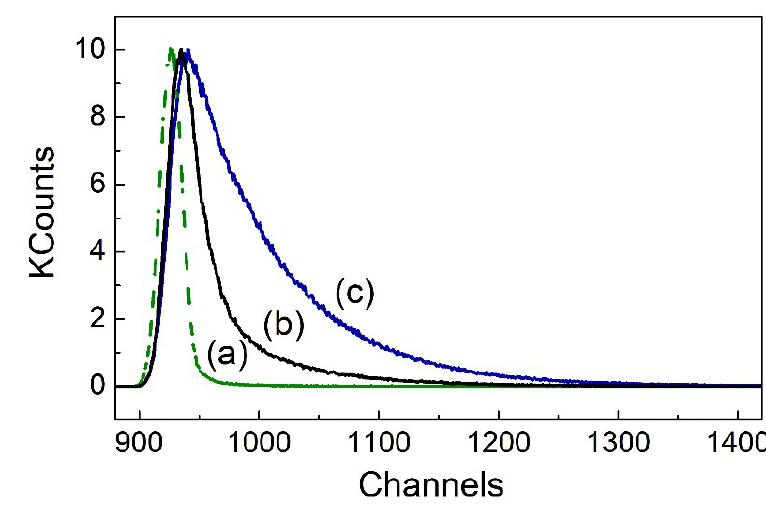
Figure 4. Lifetime measurements of compound 1 in THF ( a ), ethanol ( b ) and alkaline aqueous solutions ( c ) (concentration of 1 × 10 −5 mol/L). The time calibration is 5.487 × 10 −11 s/ch. Table 2. Lifetime results for compound 1 and compound 2 in different solvents (λ